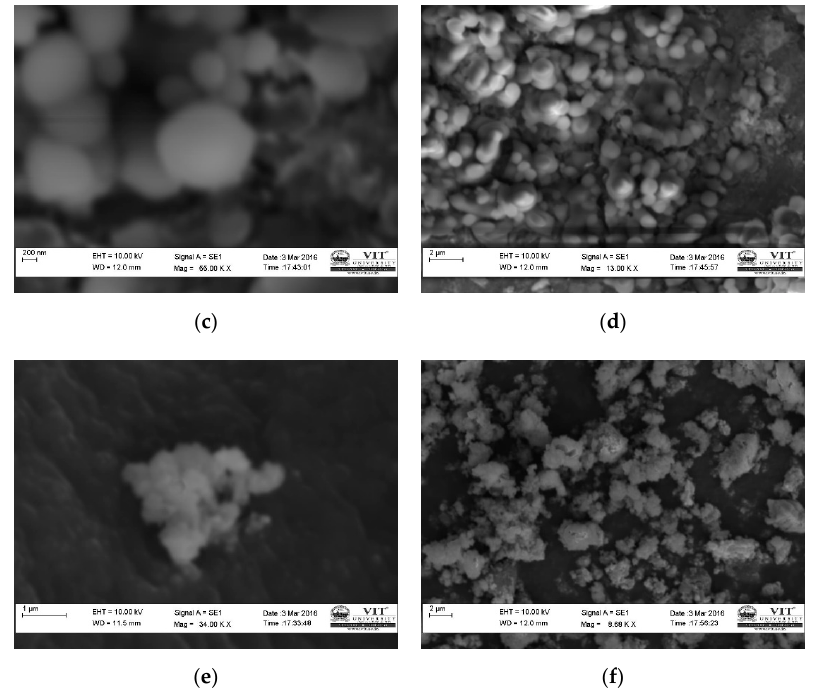
Figure 1. SEM image of nanoscale zero-valent iron (nZVI) particles: ( a , b ) from chemical synthesis; ( c , d ) using neem leaves; ( e , f ) using mint leaves.